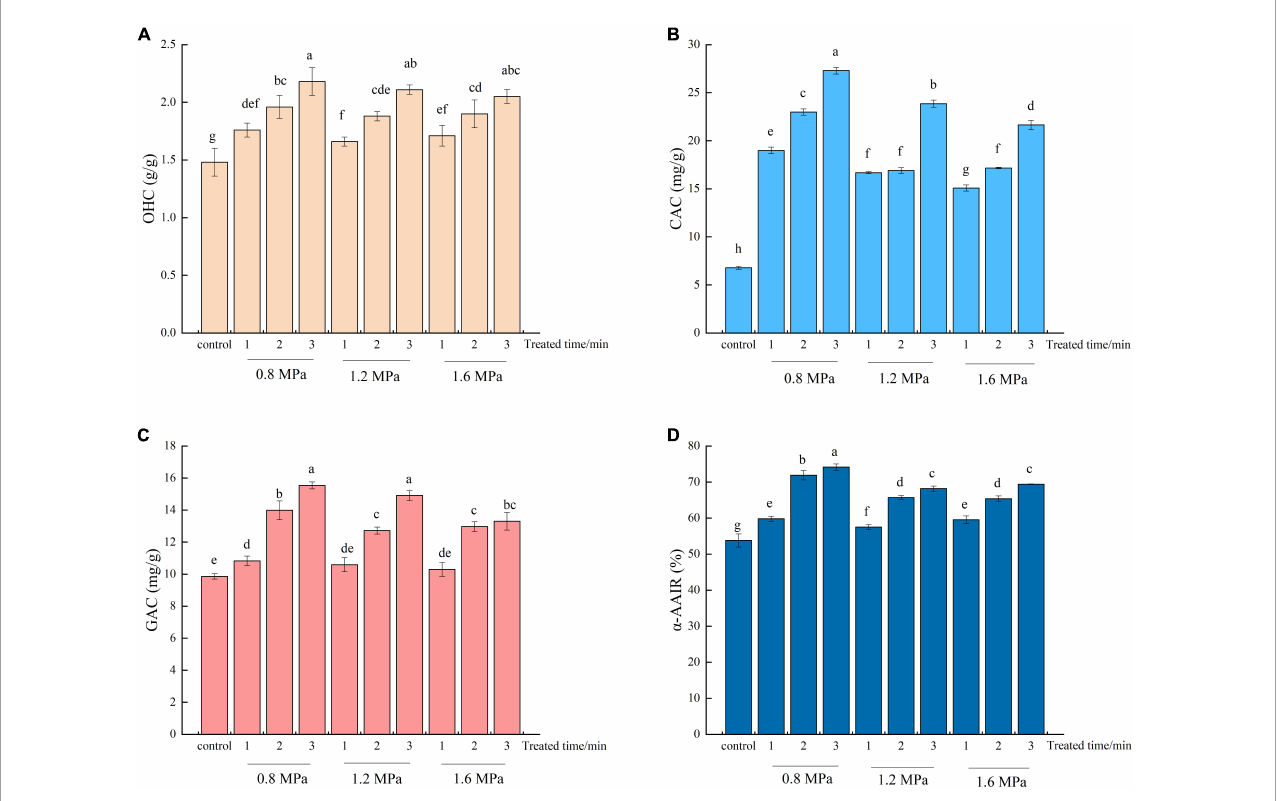
FIGURE2 The oil holding capacity (OHC) (A) , cholesterol adsorption capacity (CAC) (B) , glucose adsorption capacity (GAC) (C) and α -Amylase activity inhibition ratio ( α -AAIR) (D) of adlay bran soluble dietary fiber before and after steam explosion (SE). Different lowercase letters over column indicate significant differences ( p <